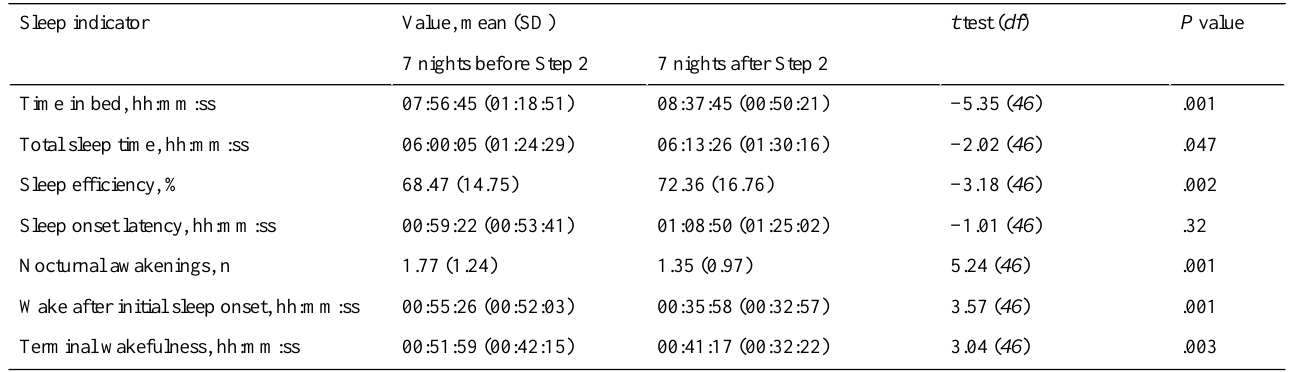
Table 4. Nocturnal sleep indicators of users completing Step 2